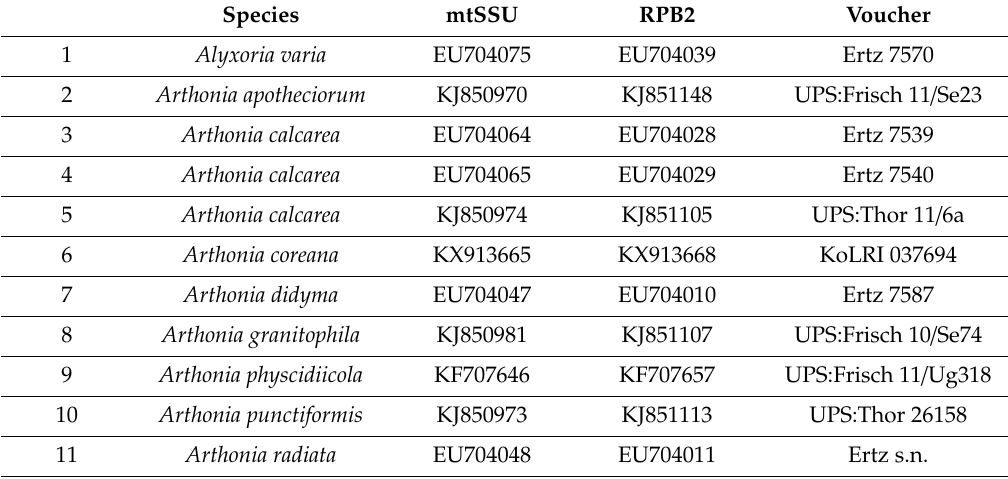
Table 1. Species list and DNA sequence information employed for phylogenetic